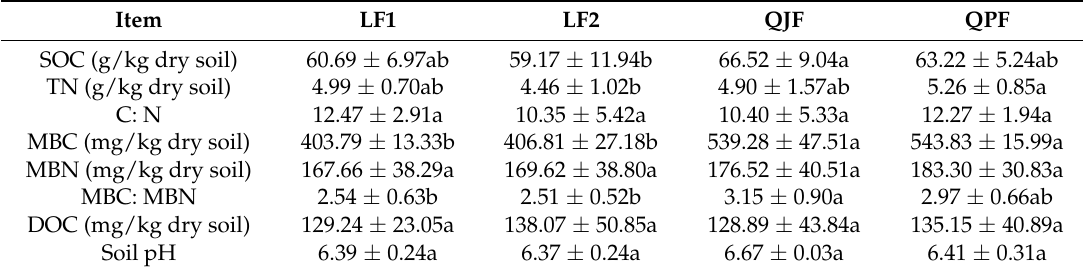
Table 4. Mean soil properties from May to November in different forest types (means ± SE, n =